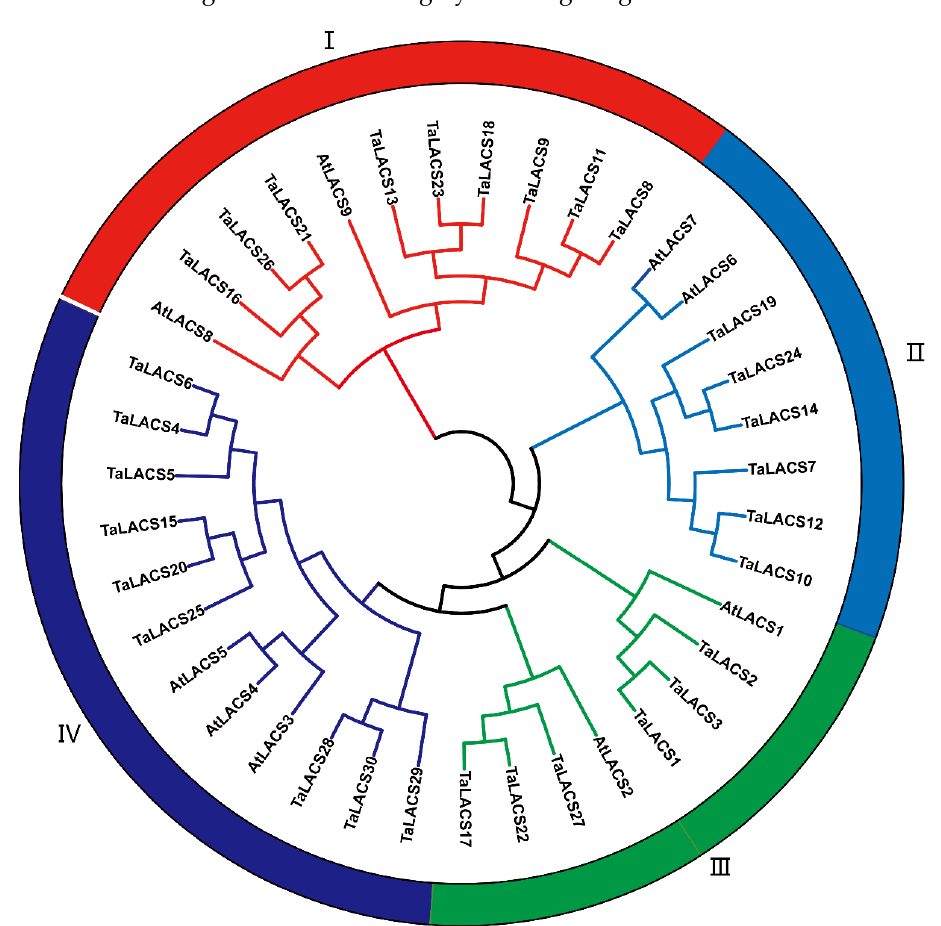
Figure 1. Phylogenetic tree of the wheat and Arabidopsis LACS family. An un-rooted neighbor joining (NJ) tree for LACS proteins was constructed, based on the amino acid sequence alignments of wheat and Arabidopsis LACS. All the proteins are clustered into four clades shown in different circles with different colors.